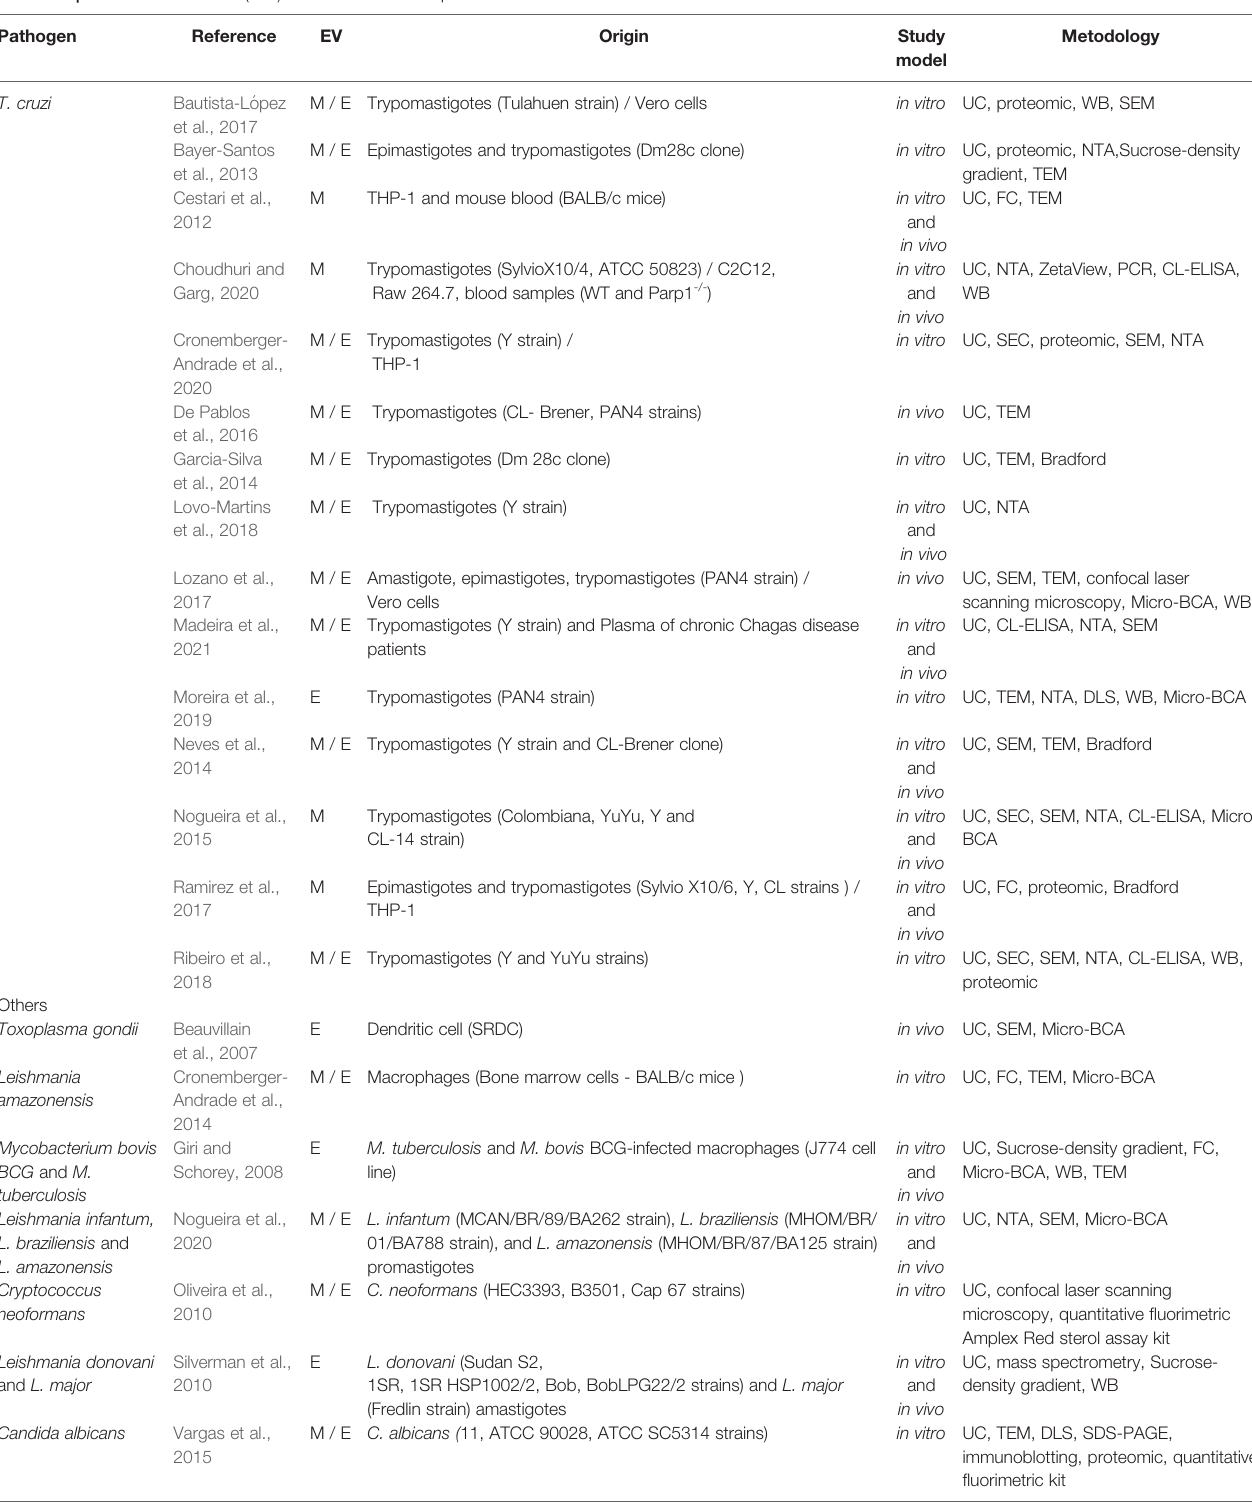
TABLE 1 | Extracellular vesicles (EVs) in T. cruzi and other